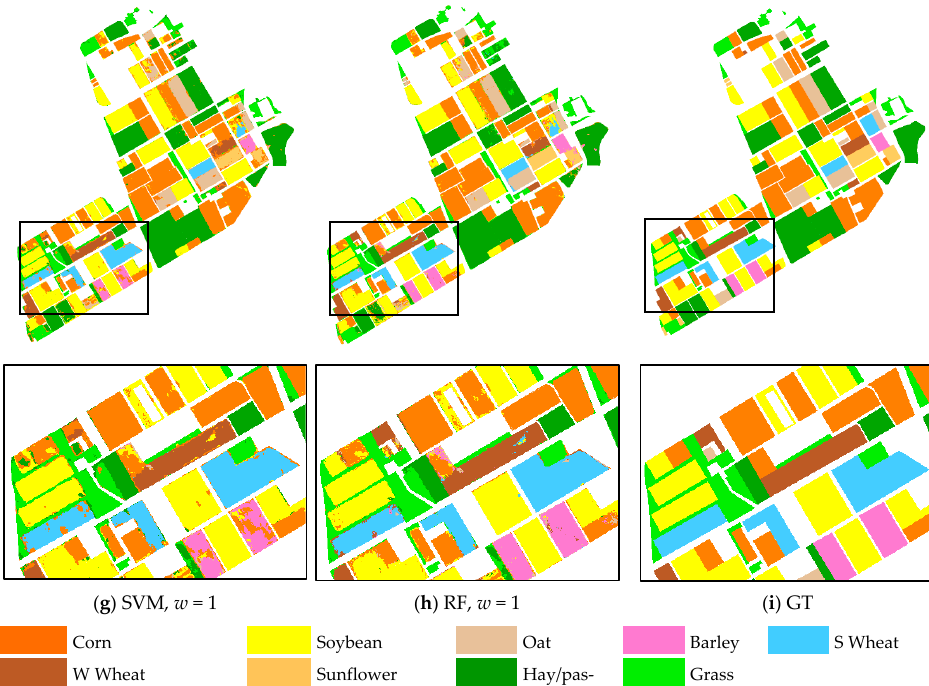
Figure 7. Classification maps obtained from ( a ) SAE, w = 1, ( b ) SAE, w = 3, ( c ) SAE, w = 5, ( d ) GFSAE, w = 1, ( e ) GFSAE, w = 3, ( f ) GFSAE, w = 5, ( g ) SVM, w = 1, ( h ) RF, w = 1, and ( i ) the ground reference map for the CEF dataset. Accuracy metrics for the Winnipeg dataset are represented in Figure 8. The results confirm that increasing spatial neighborhood window size (i.e., w from 1 to 3 pixels) in- creases the classification accuracy of SAE in all accuracy metrics (about 1%). Here, setting the window size larger than three pixels (about 15 m spatial extent), the accuracy de- creases because of the over-smoothing effect. Specifically, for the broadleaf class, which has a minimal spatial extent, the algorithm could not identify any pixels correctly (See per-class F-score for the broadleaf class of w = 5 settings in Table 5). This is due to involving 94 . many non-broadleaf pixels in classifying target broadleaf pixels.